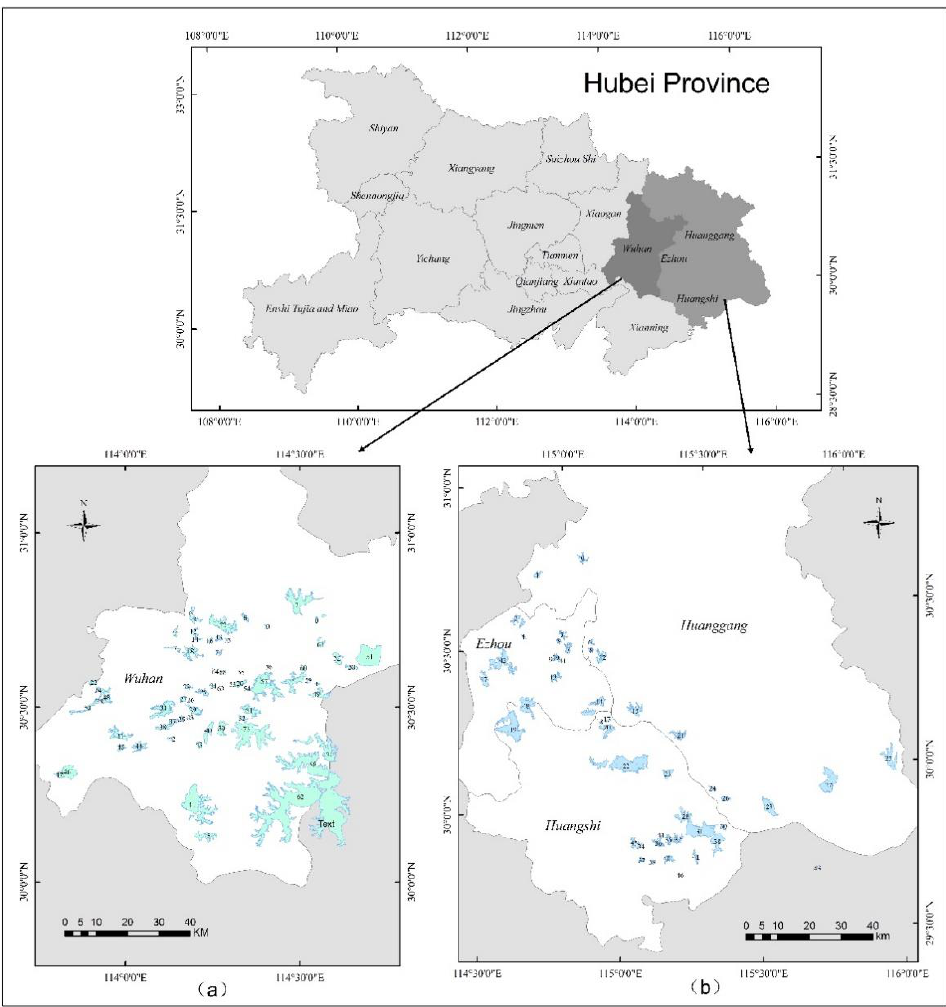
Figure 1. Study areas: ( a ) the Wuhan study area; ( b ) the Huangshi study area.